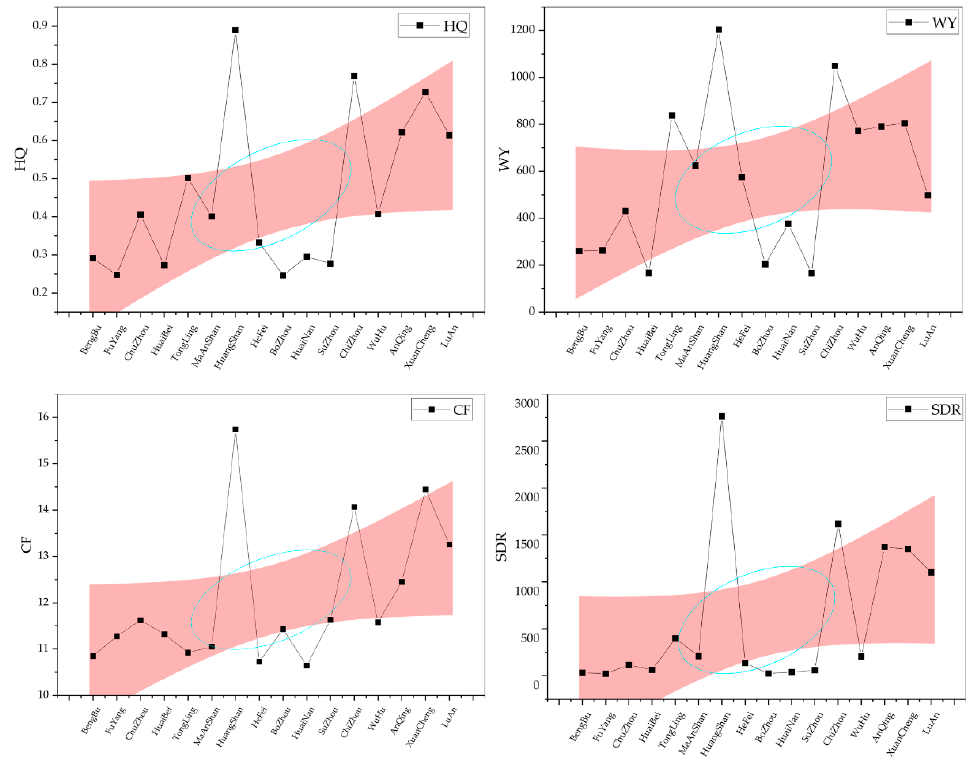
Figure 11. Ecosystem service functions of each city in Anhui Province.